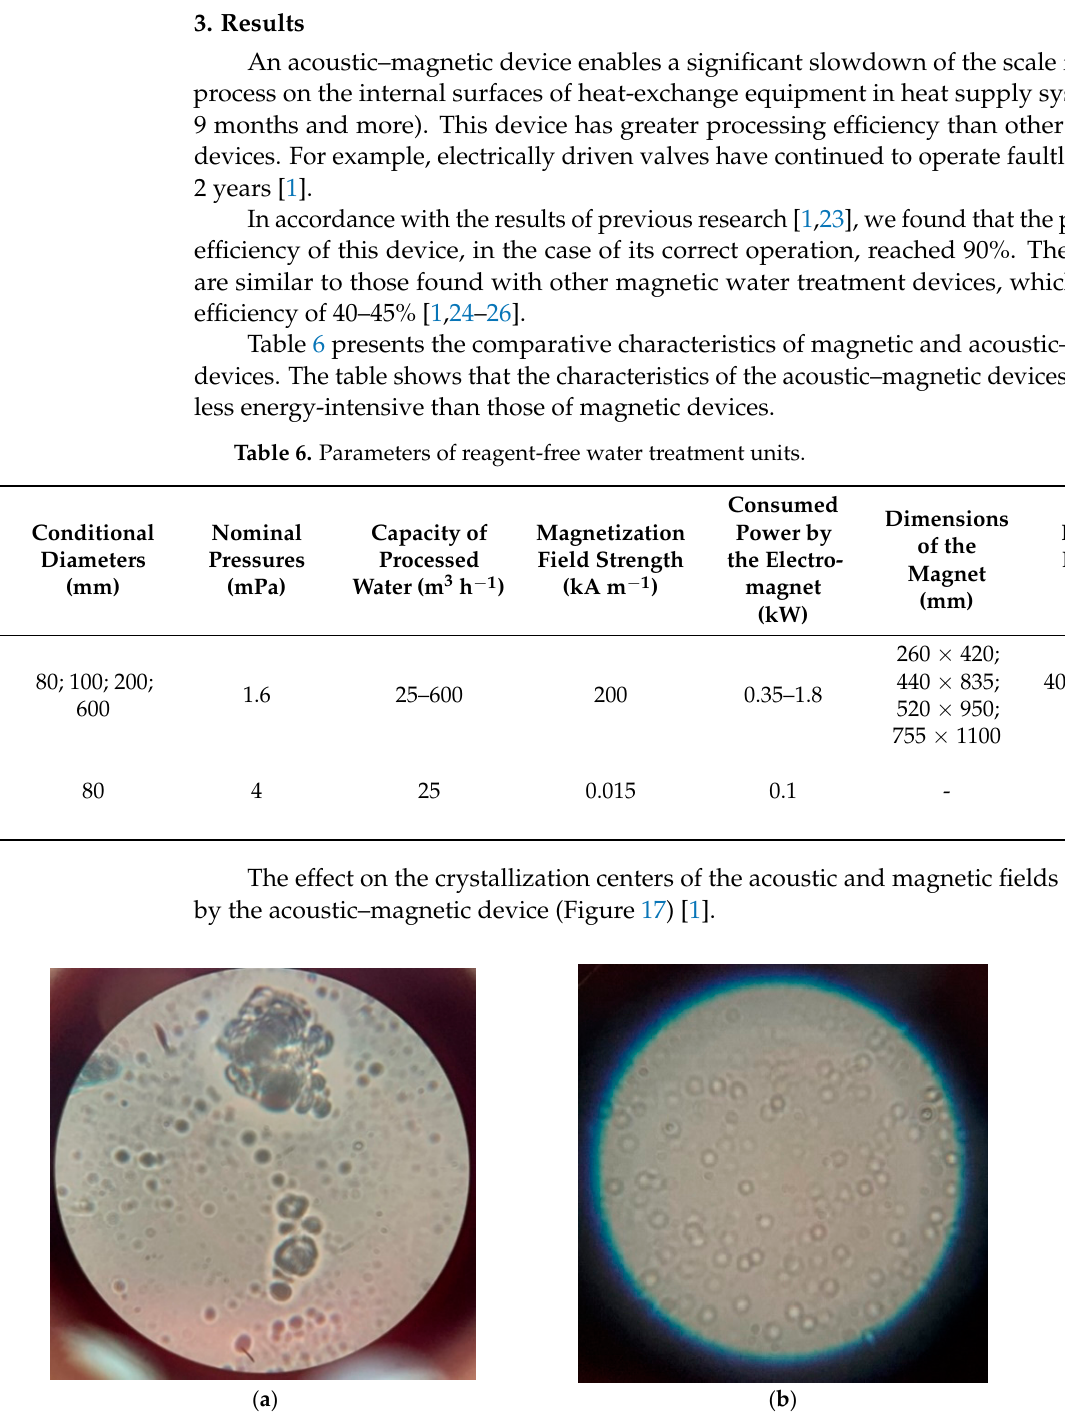
Figure 17. The geothermal water crystallization centers: ( a ) before geothermal water treatment, and ( b ) after geothermal water treatment with acoustic–magnetic devices [1].